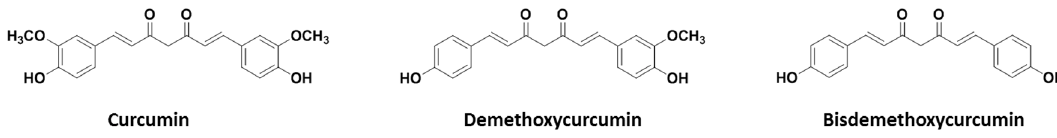
Figure 1. Chemical structure of curcuminoids.